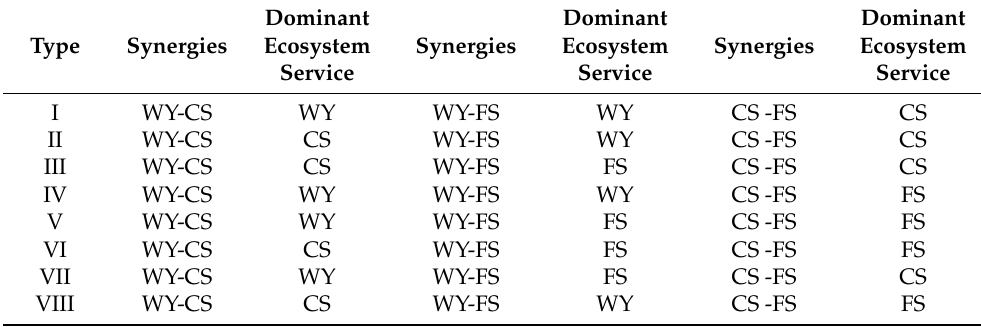
Table 4. Classification rule of dominant ecosystem service in the synergies in 2015.